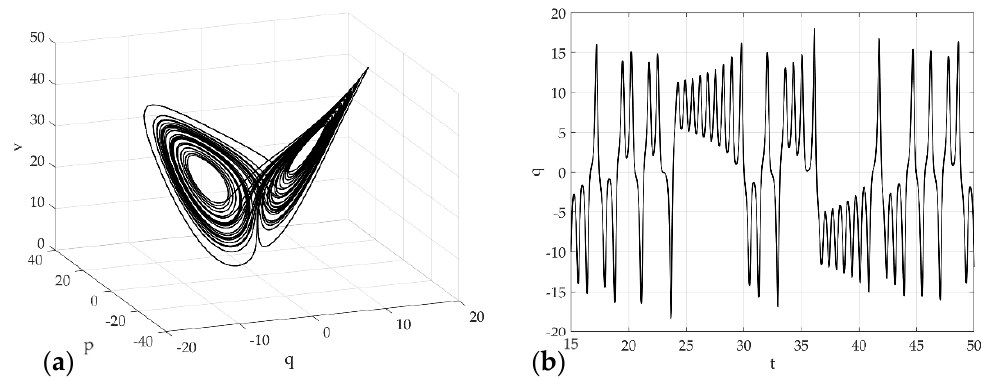
Figure 4. Chaotic attractor for the Lorenz system when σ = 10, β = 8/3, and ρ = 28; the initial conditions were q ( 0 ) = v ( 0 ) = 0 and p ( 0 ) = 1, ( a ) Phase portrait, ( b ) Time series plot of q ( t ) .